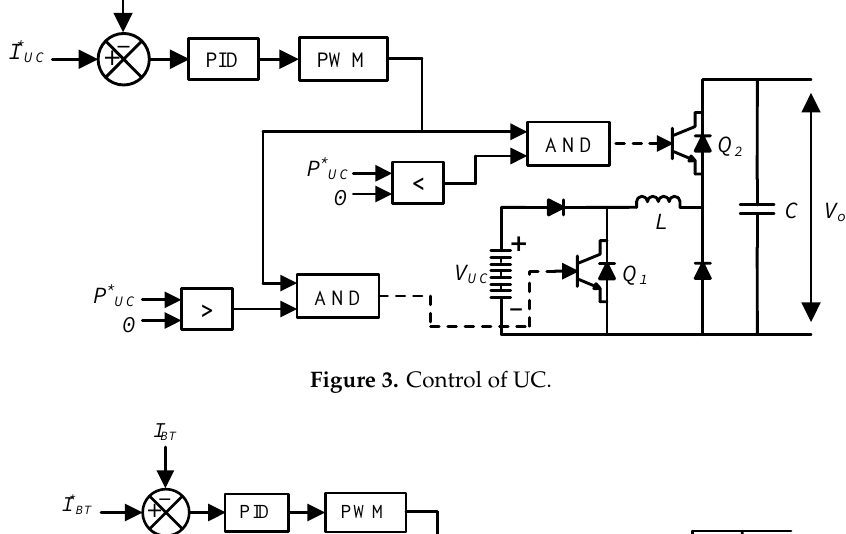
Figure 3. Control of UC.